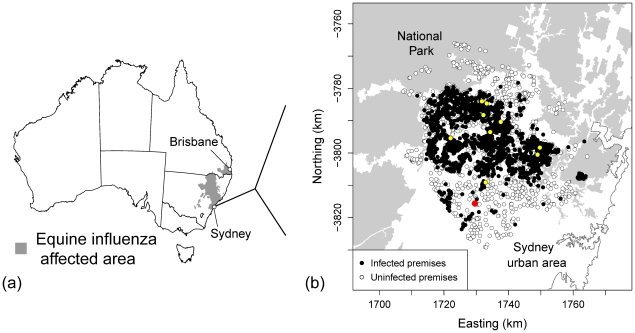
Map of Australia showing the area affected by the 2007 outbreak of equine influenza and the study extent.(a) From August–December 2007, around 70,000 horses were infected on over 9000 horse premises in two Australian States. (b) This study focused on the largest cluster (n = 3624 horse premises), northwest of Sydney, as defined by a 15 km buffer around the nine earliest infected premises (depicted in yellow) that were contact-traced to events where disease transmission was known to have occurred in the first week of the outbreak. Clinical signs were first observed on 17 August 2007 in a horse in quarantine at Eastern Creek Quarantine Station (red closed circle). The cluster is surrounded by national parks and Sydney urban areas. (For interpretation of the references to colour in this text, the reader is referred to the web version of the article.).